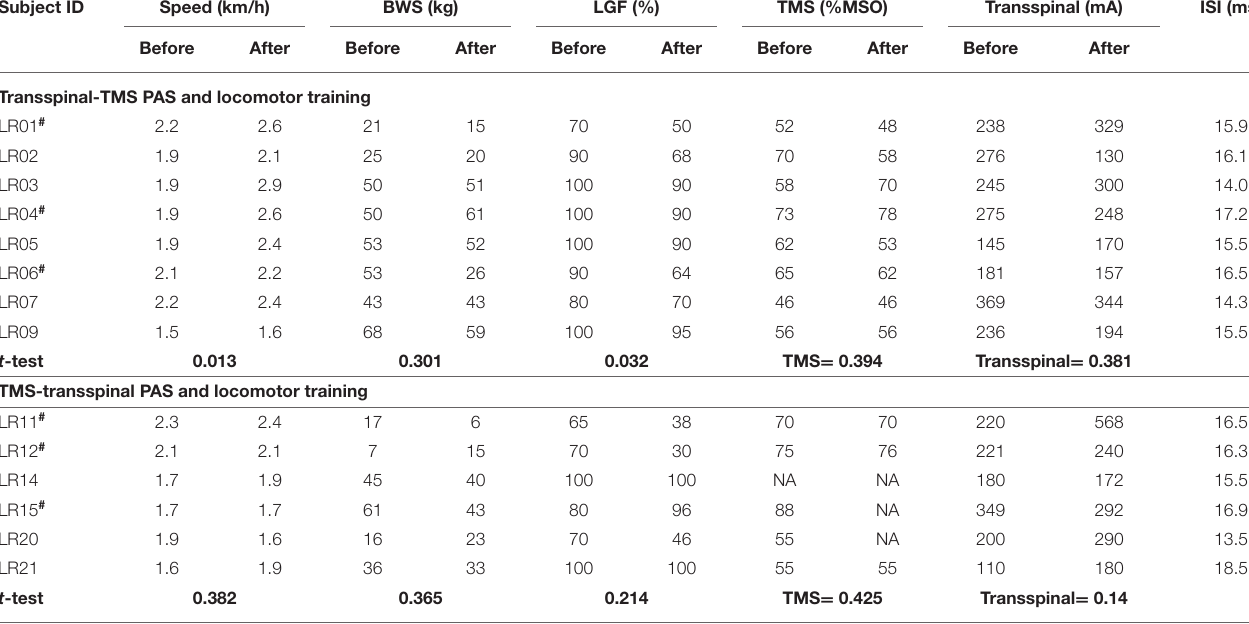
TABLE 2 | Training intervention